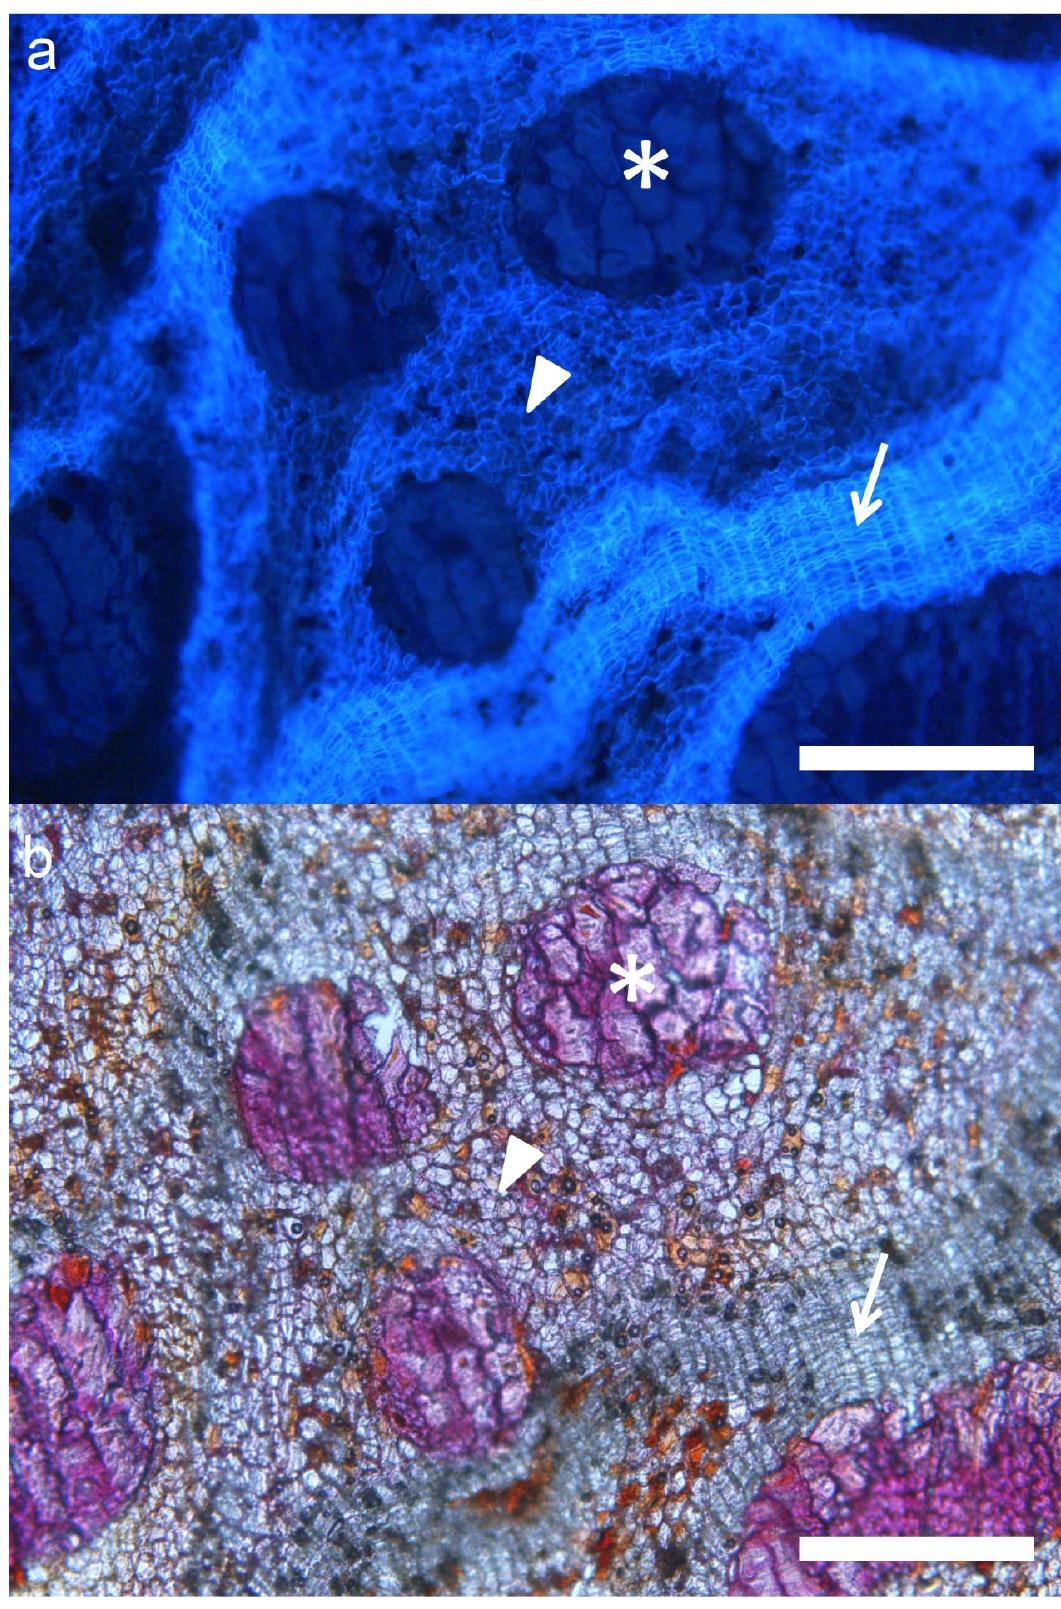
Figure 2. Cross section of the bark of a hybrid tree under UV ( a ) and visible light ( b ). Periderms (arrow), schlerenchymatic nodules (asterisk), and a high proportion of suberized inactive phloem (arrowhead) can be seen. Bar scale: 200 μm.